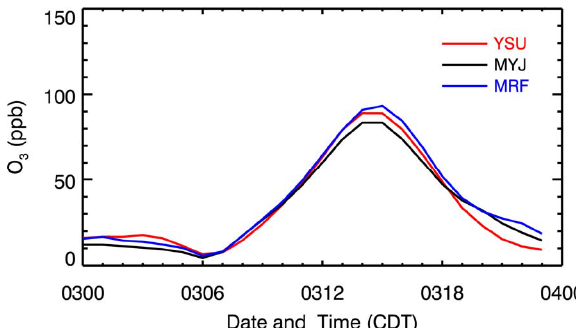
Fig. 11. Temporal evolution of the ensemble mean surface [O 3 ] averaged over the RAMA sites using three different PBL schemes (YSU, MYJ, and MRF